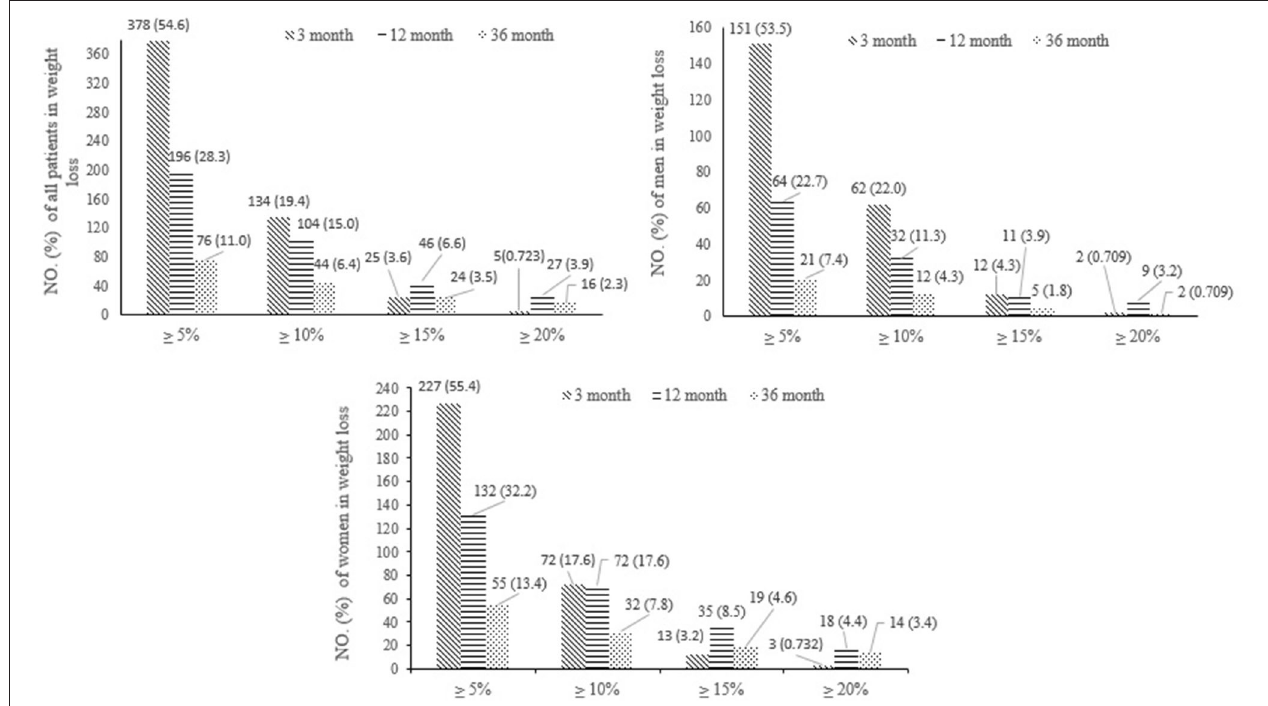
FIGURE 1 | Effects of interventions on weight loss in total 692 participants from the baseline weight at 3, 12, and 36-month